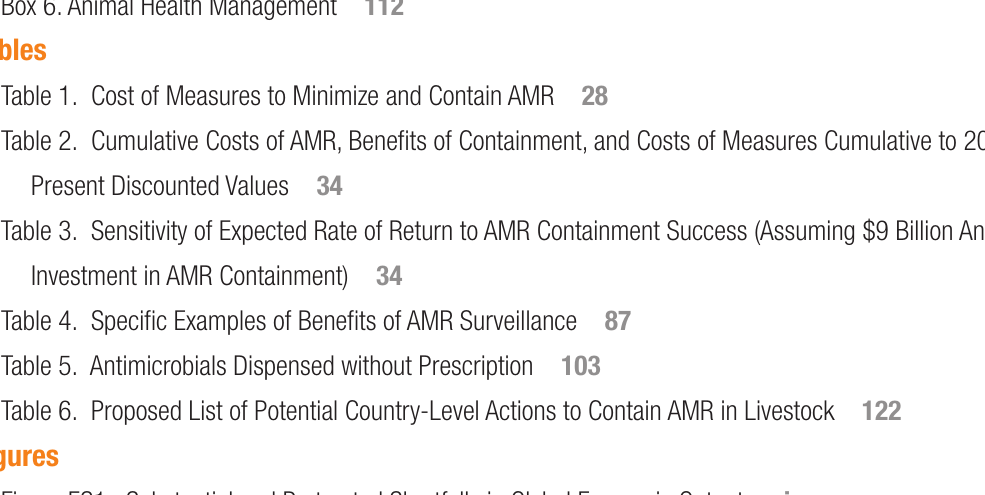
Figure ES1. Substantial and Protracted Shortfalls in Global Economic Output xix Figure ES2. Economic Costs of AMR May Be as Severe as During the Financial Crisis xix Figure ES3. High-Income and Upper Middle-Income Economies Stand to Benefit the Most from AMR Containment, Both in Absolute and per Capita Terms xxi Figure ES4. Five Objectives of the Global Action Plan on AMR, 2015–19 xxiii Figure 1. AMR Makes TB Far Costlier to Treat 13 Figure 2. Substantial and Protracted Shortfalls in Global Economic Output 18 Figure 3. Economic Costs of AMR May Be as Severe as During the Financial Crisis 19 Figure 4. AMR Impact on World Trade 20 F igure 5. Decline in Livestock Production Could Be Substantial and Most Pronounced in Low-Income Countries 21 Figure 6. Health Care Costs Reach Nearly $1.2 Trillion in the “High-AMR” Case 21 Figure 7. Most of the People Falling into Extreme Poverty Because of AMR Will Be in Low-Income Countries 22 Figure 8. The Five Objectives of the WHO Global Action Plan on AMR, 2015–19 Figure 9. Synergies and Tensions with Global Development Goals for 2030 Figure 10. National and International Plans to Tackle AMR: Year of Implementation and Duration Figure 11. High-Income and Upper Middle-Income Economies Stand to Benefit the Most from AMR Containment, Both in Absolute and per Capita Terms Figure 12. Global AMR Surveillance Networks Figure 13. Location of Satellite Laboratories Figure 14. Top Five Active Ingredients According to Number of Brand Names 42 Figure 15. Distribution of “Simulated Self-Referred Patient” Visits That Ended with Dispensation of an Antimicrobial, by Country